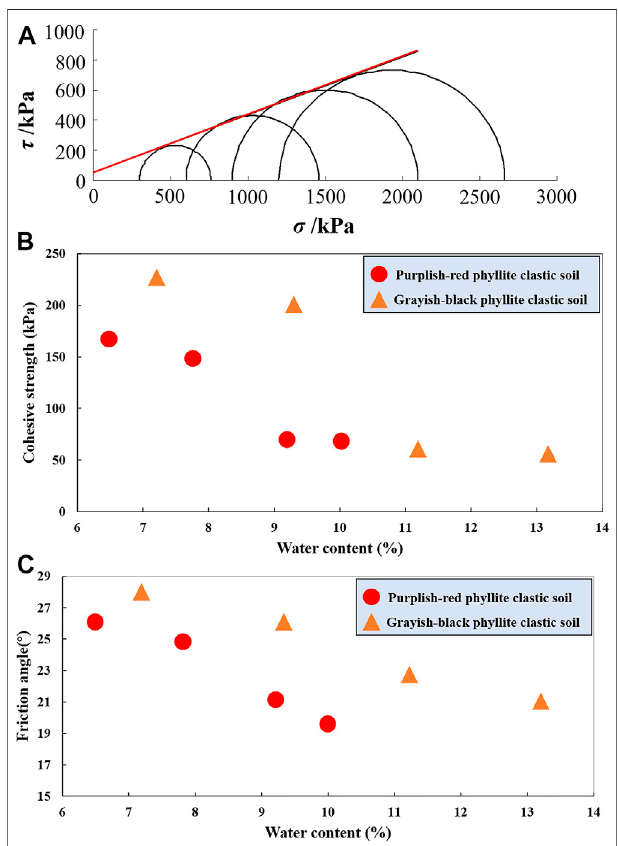
FIGURE 3 | Strength curves: (A) strength envelope; (B) relationship between cohesion and water content; (C) relationship between friction angle and water